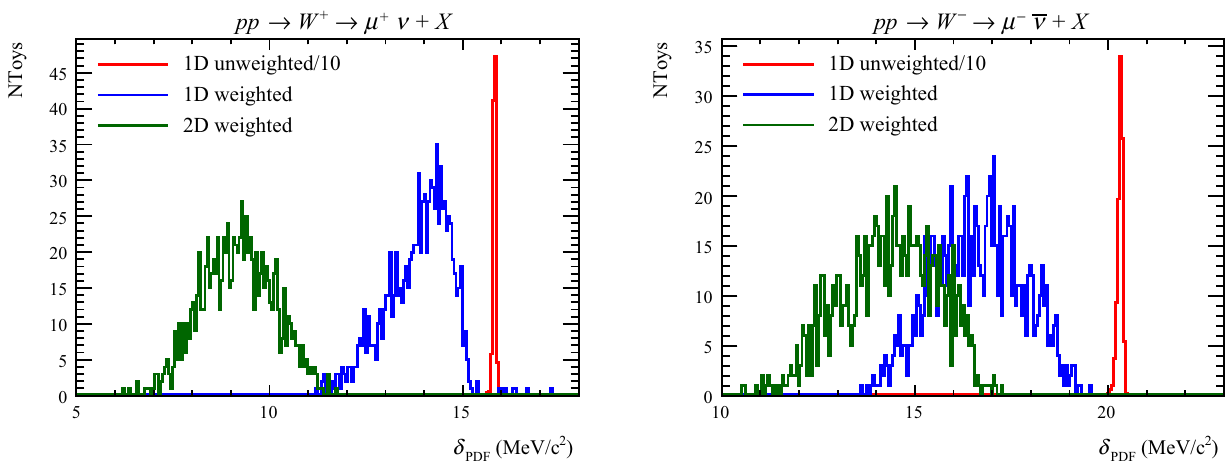
μ μ fit without weighting, p fit T T